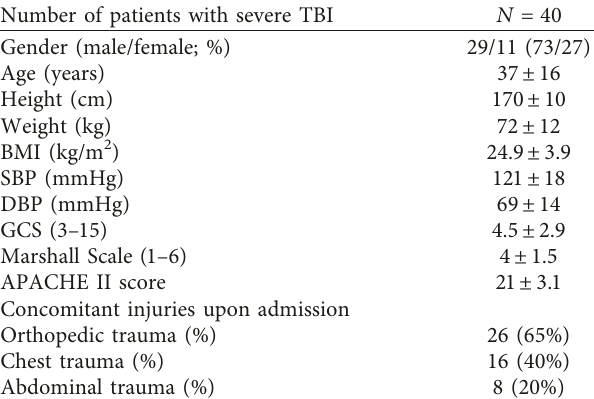
Table 2: Baseline features of the study population upon admission.